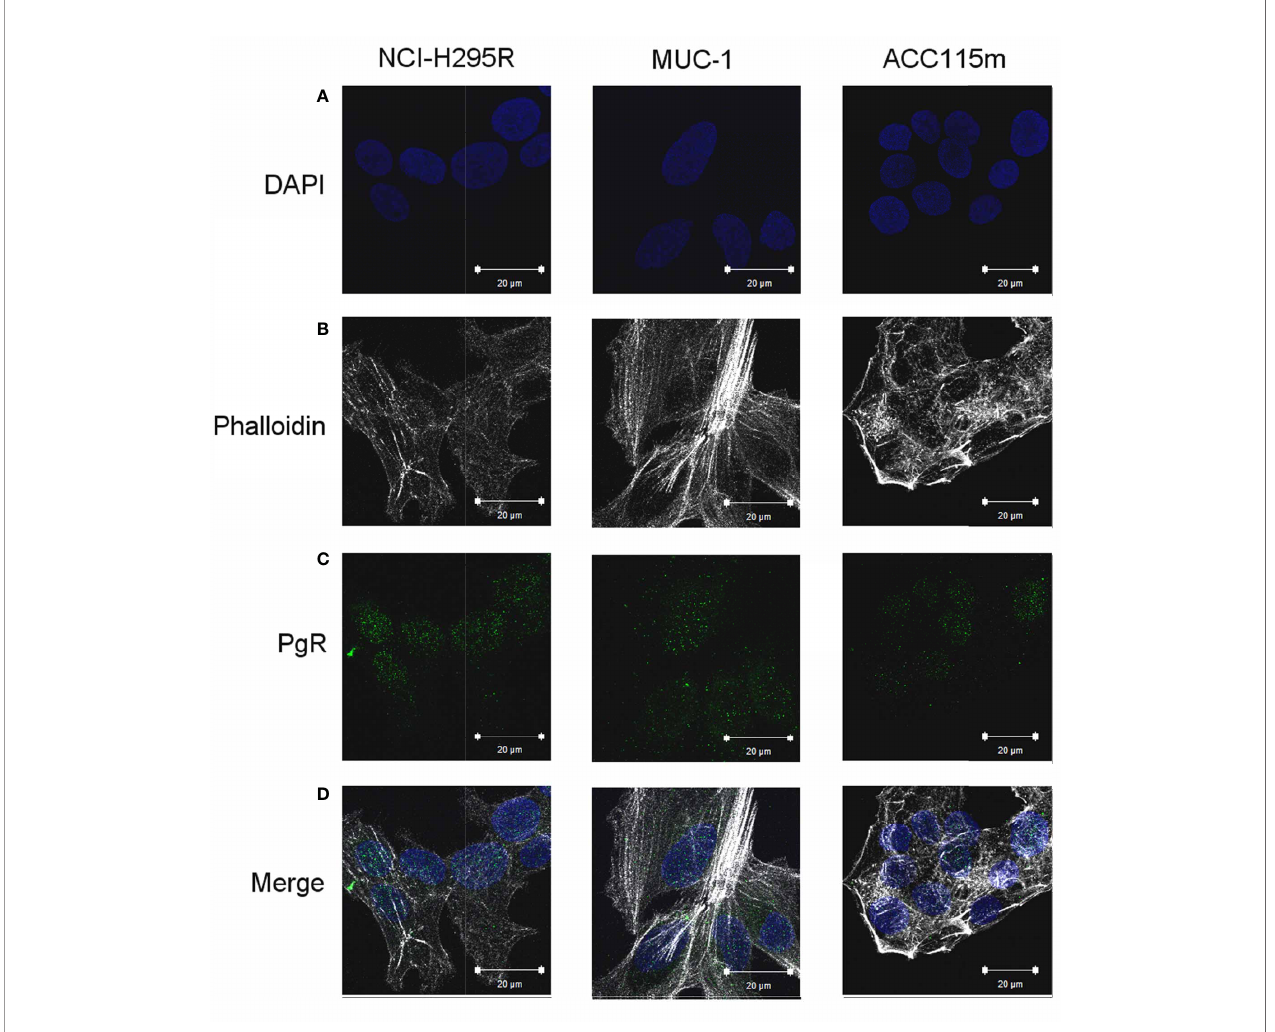
FIGURE 4 | PgR expression in NCI-H295R, MUC-1 cell lines and ACC115m primary culture. Cells were seeded on poly-L-lysine pre-treated coverslips following by incubation with DAPI for nuclear staining. Panel (A) DAPI; panel (B) phalloidin; panel (C) : PgR; panel (D) : merge. The scale bar of 20 µm is automatically inserted by the software ZEN